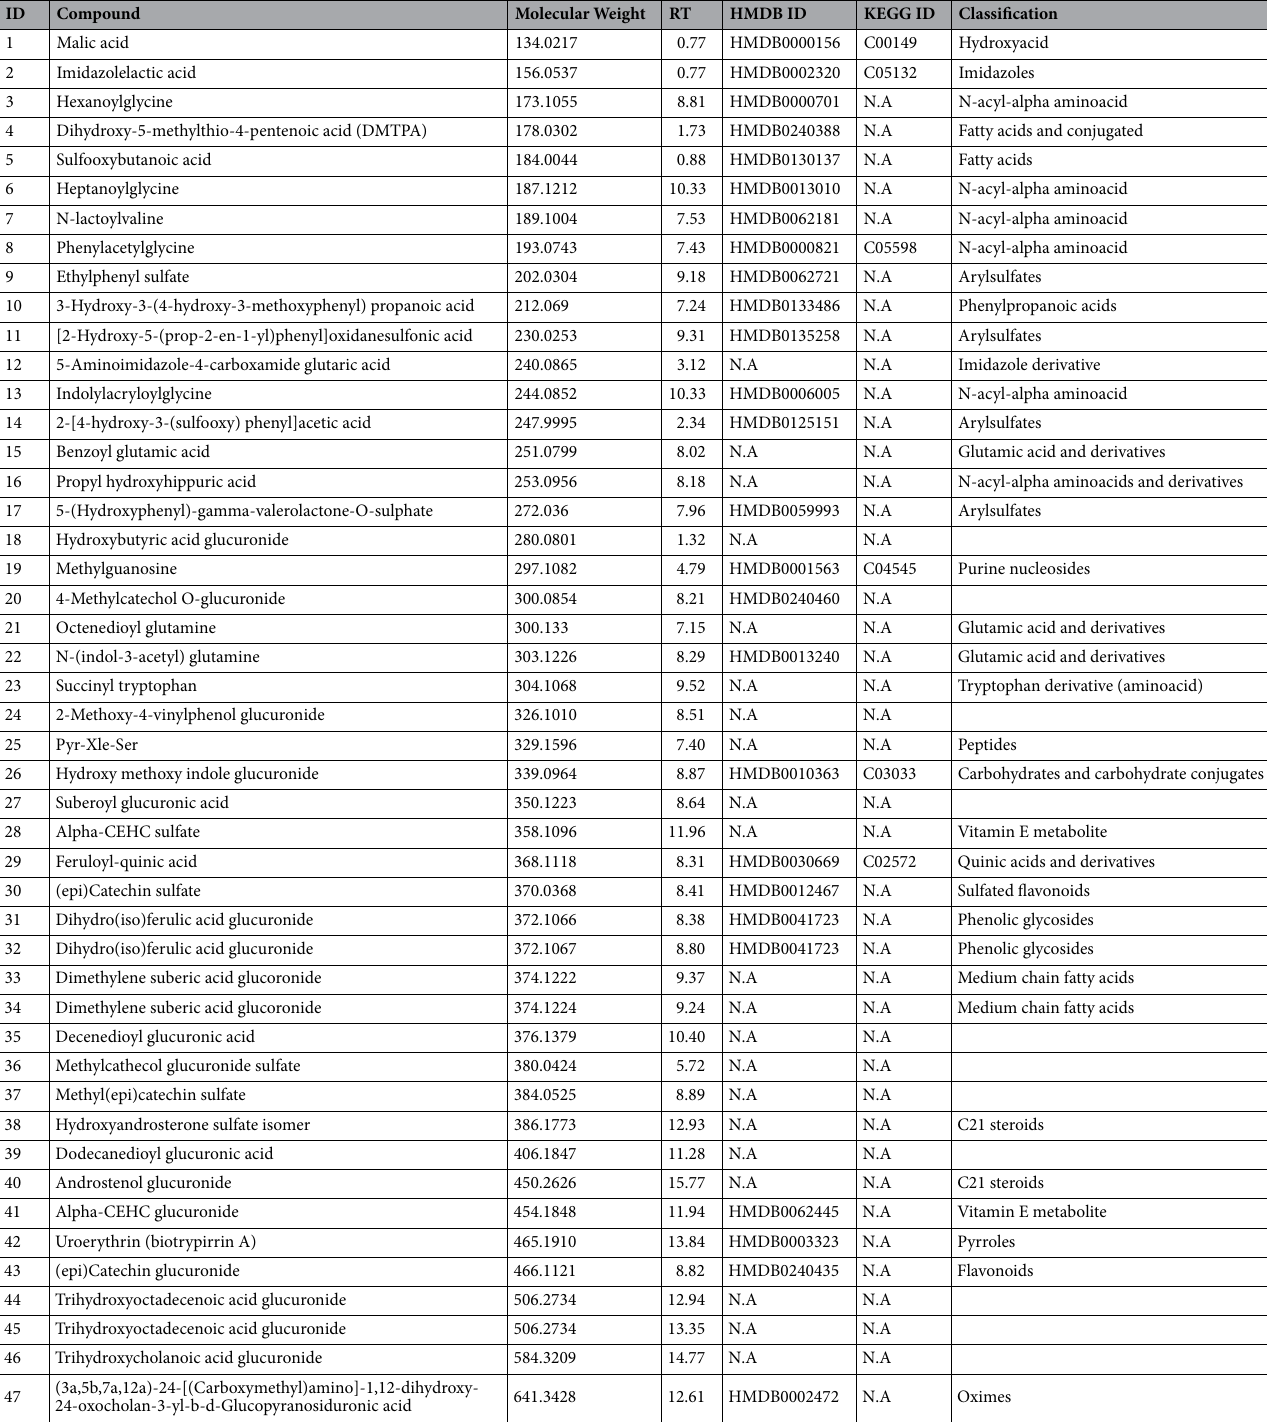
Table 2. List of ESI– metabolites, together with their molecular weights, chromatographic retention times, Kegg and HMDB IDs, and HMDB classification, when available. The numerical IDs in the first column correspond to those used in Fig.